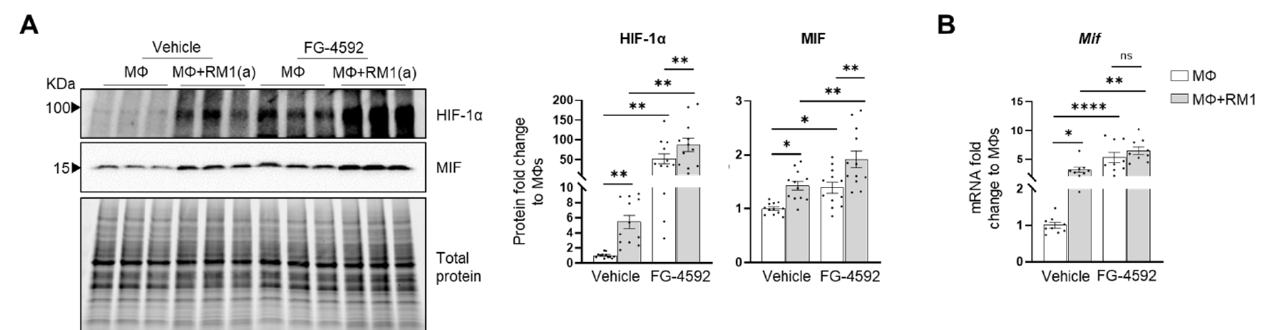
Figure 6. Efferocytic BM macrophages stabilize HIF-1 α and induce MIF expression. BM macrophages (M Φ ) were isolated from C57BL/6J mice and co-cultured alone or with apoptotic RM1(a) cells and treated with FG-4592 (Roxadustat, a HIF prolyl-hydroxylase inhibitor (10 µM)) or vehicle control for 16–18 h. ( A ) Protein lysates from co-cultures were analyzed by Western blotting with HIF-1 α and MIF antibodies ( n = 12/group). ( B ) mRNAs were isolated from co-cultures and analyzed by RT-qPCR for Mif expression ( n = 9/group). Graphs show the fold change of each group relative to vehicle-treated BM macrophage control. The Western blots shown in A are representative images. Plotted data are shown as mean ± SEM; * p < 0.05, ** p < 0.01, **** p < 0.0001, ns = not significant (repeated measures one-way ANOVA; Tukey’s multiple comparison test).